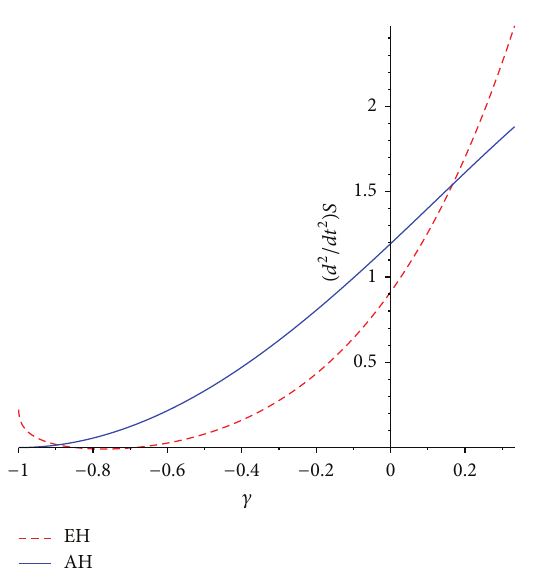
Figure 4: TE for RSII brane for Modified Chaplygin Gas.